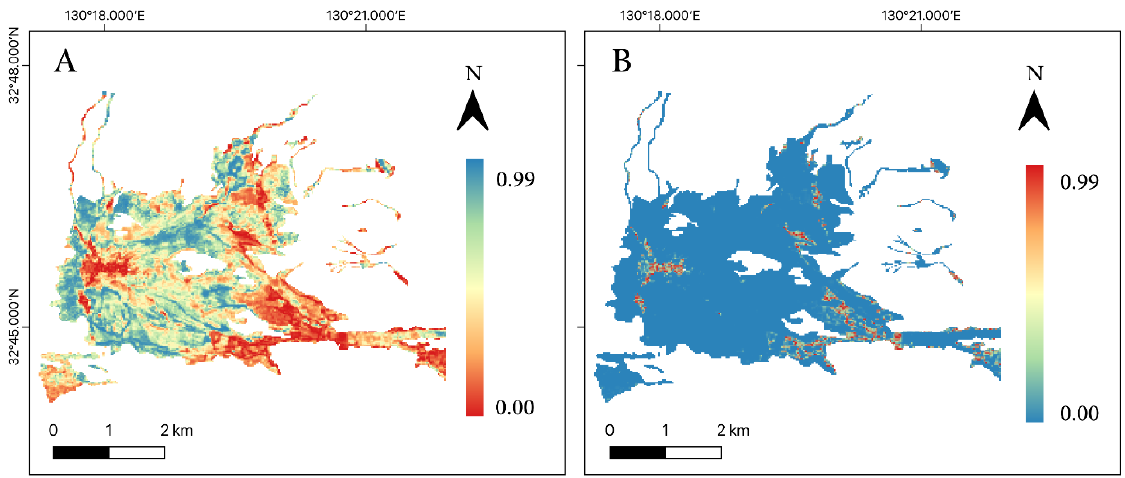
Figure 5. Average recovery curves from each disturbance type with one standard deviation repre- sented.